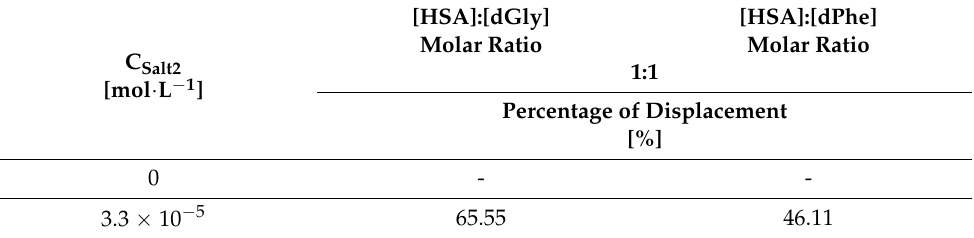
Table 7. The percentage of displacement of dansylated amino acids from the HSA molecule in the presence of Salt2 with increasing concentration; [HSA]=[dGly]=[dPhe]=[Salt2] 5 × 10 − 6 mol · L − 1 ; λ ex 350 nm.